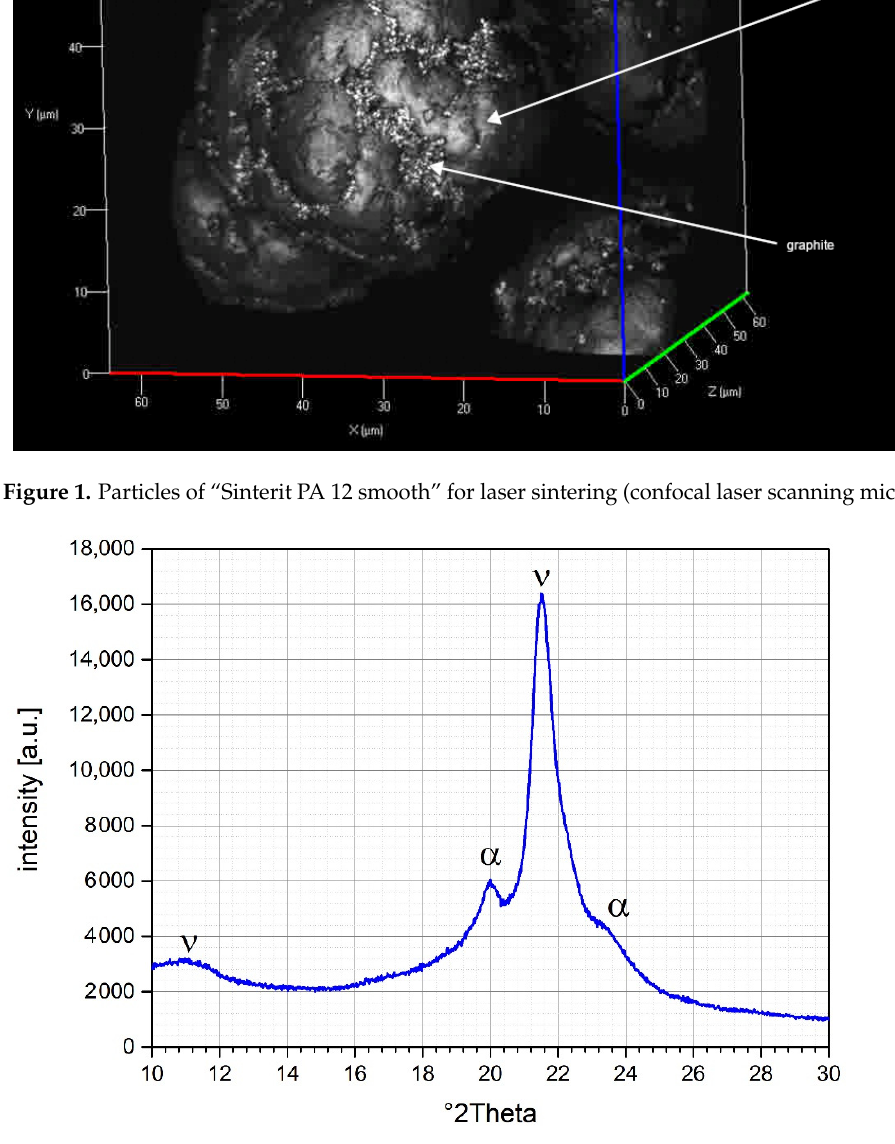
Figure 2. X-ray diffraction patterns of PA12 sample PA 12.